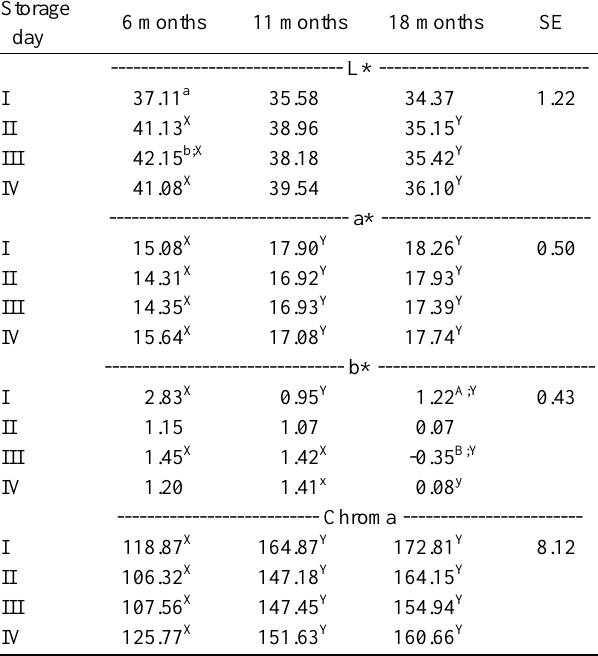
Table 2. Influence of slaughtering age on colorimetric parameters of daily renewed cutting surface (DRCS) during the four post- thawing days (Least square means  standard